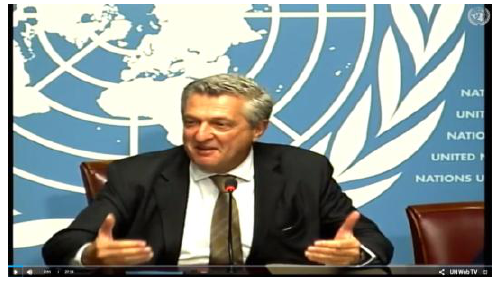
Figure 2. Press Conference release of Filippo Grandi’s